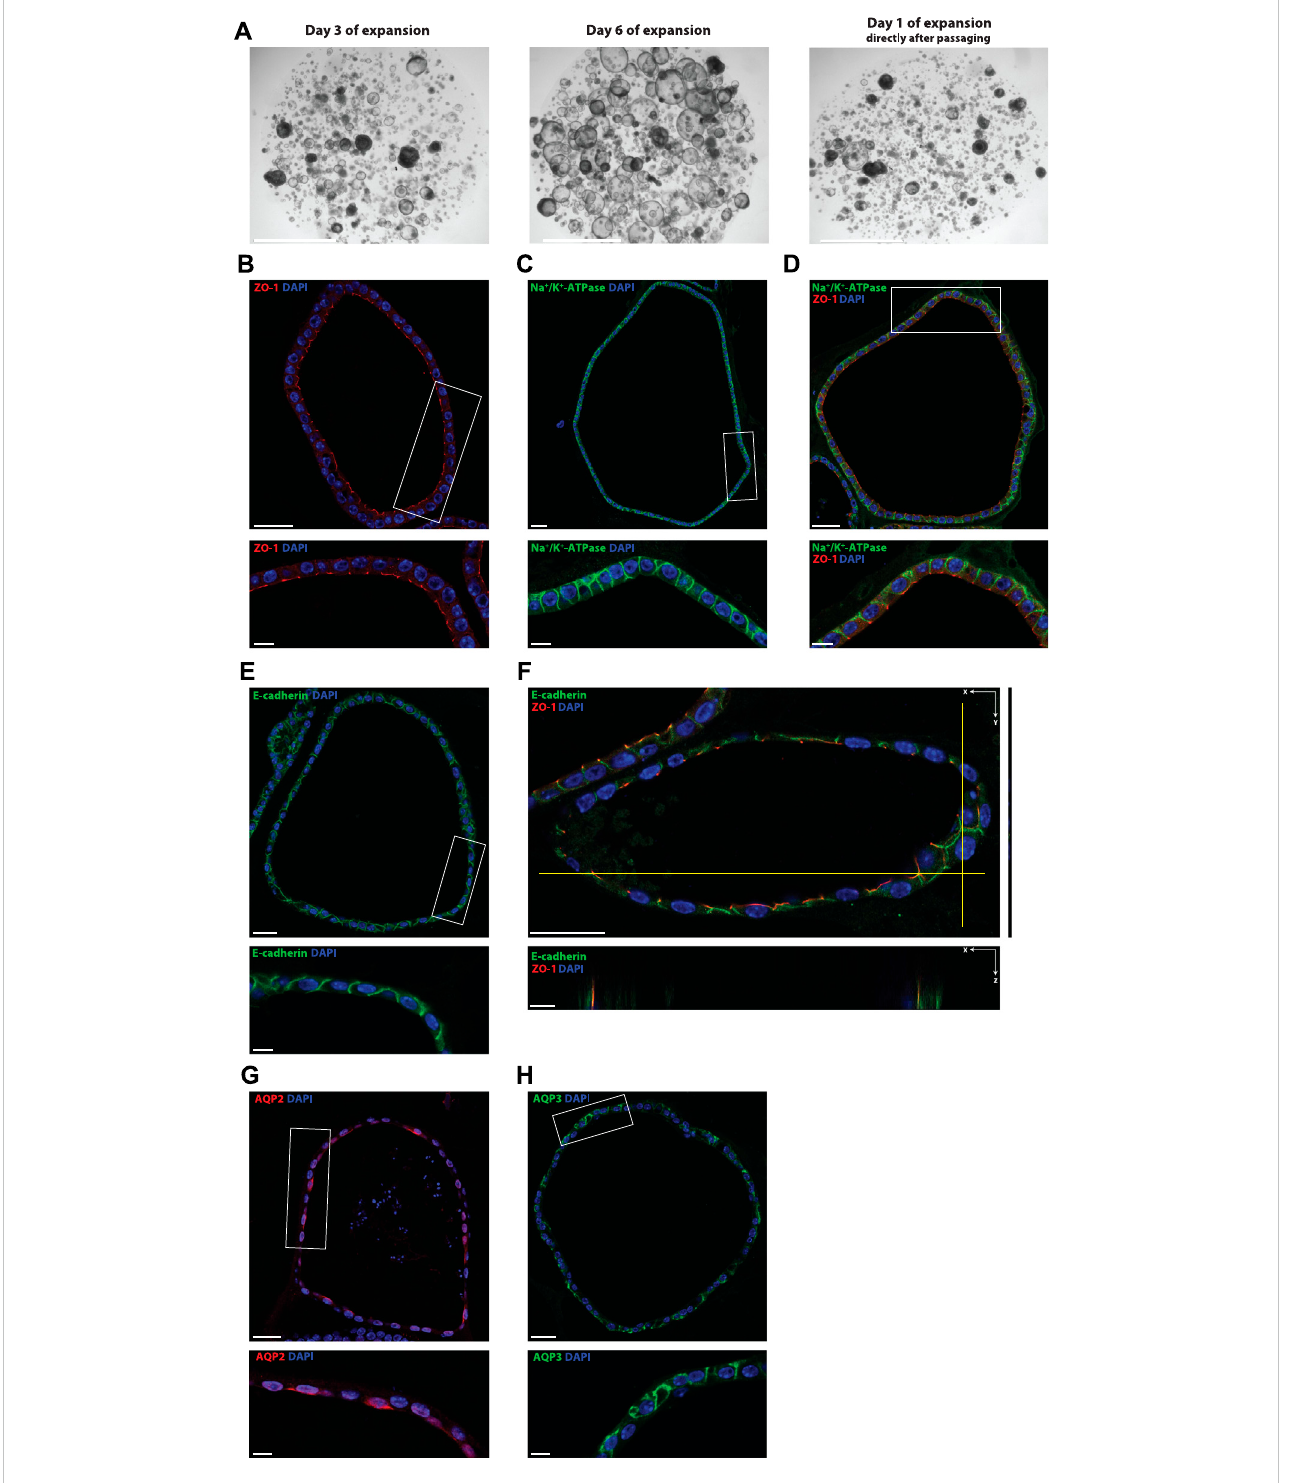
FIGURE 2 Mouse tubuloids enriched for the CD are polarized and express CD proteins (water channels AQP2/AQP3). Bright fi eld images of tubuloids growth after 3 and 6 days in culture with EM. Tubuloids were passaged after 7 days in culture, this is referred to as day 1 of expansion directly after passaging (A) . Representative immuno fl uorescence pictures of CD-enriched mouse tubuloids (B – H) . Expression of the apical tight junction protein ZO-1 (red) (B, D, F) , basolateral Na + /K + -ATPase (green) (C, D) and lateral adherens junction protein E-cadherin (green) (E, F) . Staining of CD proteins AQP2, apical water channel, (red) (G) and AQP3, basolateral water channel, (green) (H) after CD enrichment with CM, which includes forskolin. Inserts (white rectangle) are displayeddirectlybelowthemainimage (B – H) . XZ directionofZ-stackofthecostainingofZO-1andE-cadherinisdisplayeddirectlybelowthemainimage (F) . Tubuloids were stained for nuclei (DAPI, blue) (B – H) . Scale bars (A) 2 mm, (B – H) 30 μ m and inserts/z-stack 10 μ m. CD; collecting duct, EM; expansion medium, CM; collecting duct differentiation medium, ZO-1; zonula occludens 1, Na + ; sodium, K + ; potassium, AQP2/3; aquaporin